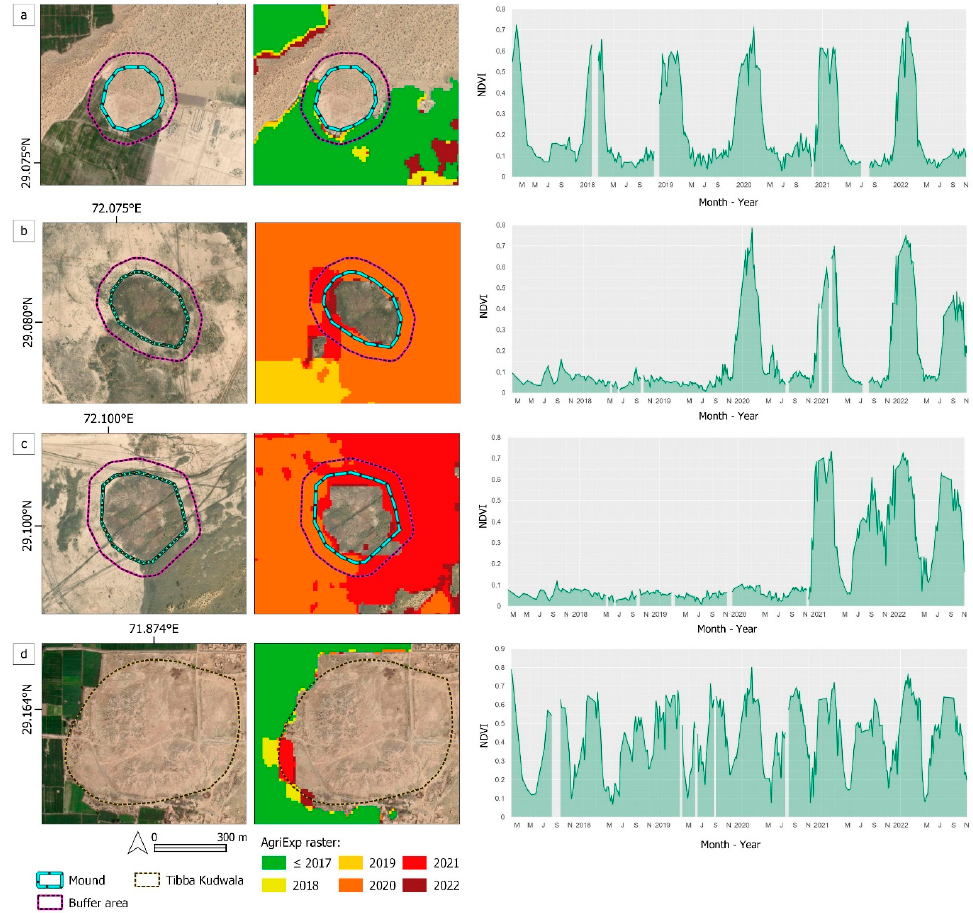
Figure 8. Sentinel-2’s average maximum index values showing different crop cycles and the pace at which agriculture is advancing towards desert rangelands. ( a , b ) The occurrence of recent winter crops in dahar mudflat areas; ( c , d ) the occurrence of summer and winter crops in dahar areas and in the fields encircling the archaeological mound of Tibba Kudwala, respectively. Base map: Google Imagery and Bing Maps.